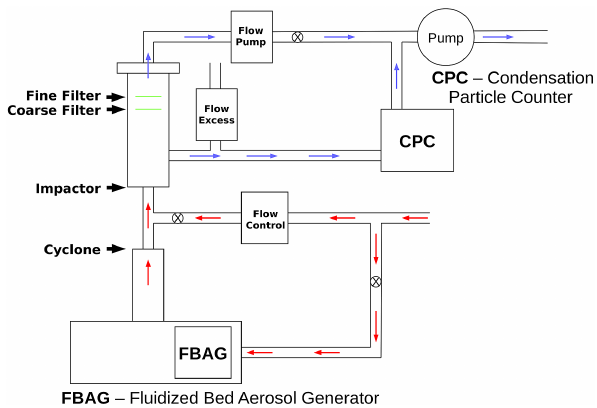
Figure 2. Sketch of experimental set-up showing the Fluidized Bed Aerosol Generator (FBAG) at the bottom with air flow lines for aerosol